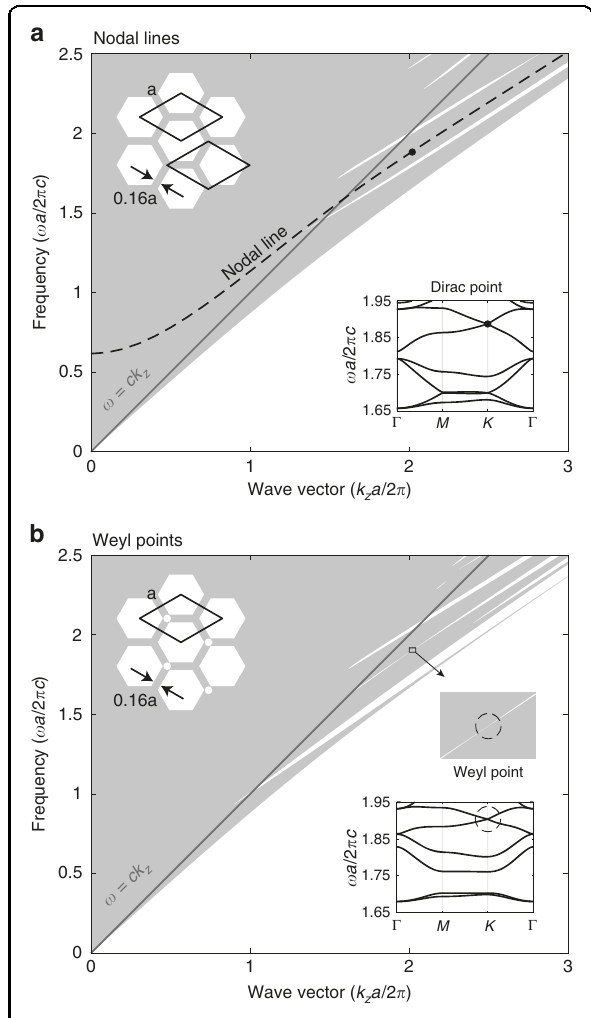
Fig. 2 Band diagram of silica ( ε = 2.1) photonic crystal lattices uniform in the out-of-plane direction ( z ). a Projected band diagram of the triangular photonic crystal, in which the nodal-line degeneracy is highlighted. b An extra air hole in the primitive-cell breaks the inversion symmetry, and the nodal-line is lifted into Weyl points. Insets: cross-section structures and in-plane band structures at k z a /2 π = 2.02. Two different primitive-cell choices are drawn in